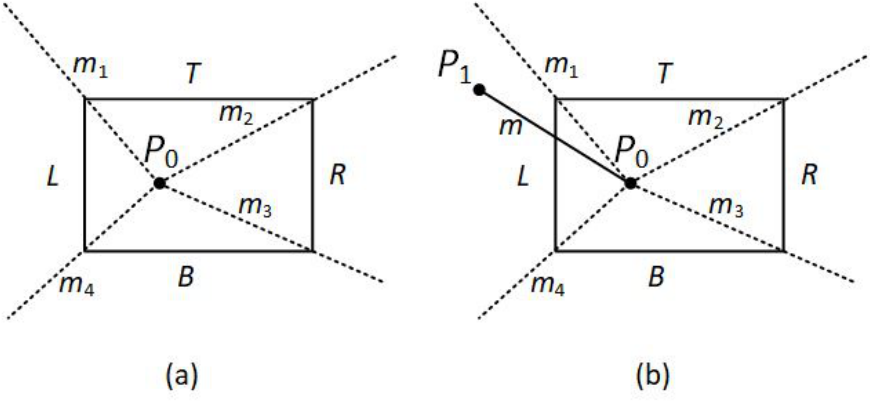
Figure 14. The two possible sets of clipping regions used in the NLN algorithm when P 0 is ( a ) above and ( b ) to left of the clipping window.